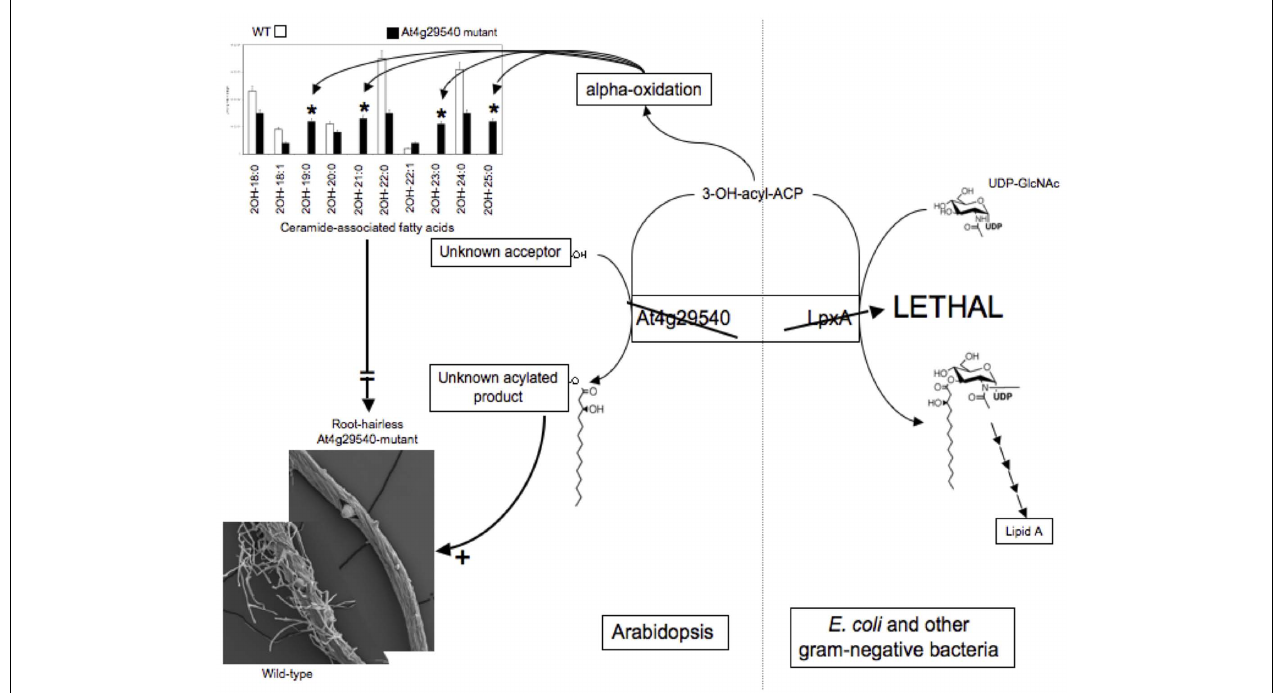
FIGURE 6 | Schematic representation ofAt4g29540-functionality based on metabolomics